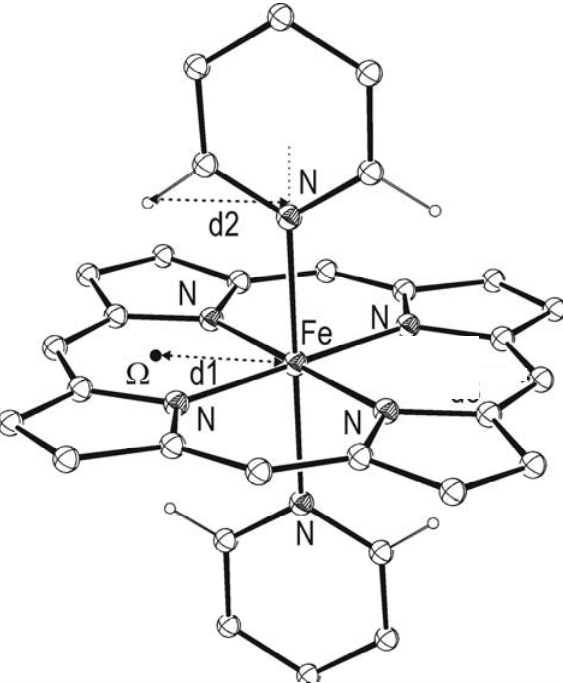
Figure 5. Crystal structure of CPOEFE10 representing some of significant distances. Some of atoms have been omitted for clarity. Coordinates are taken from